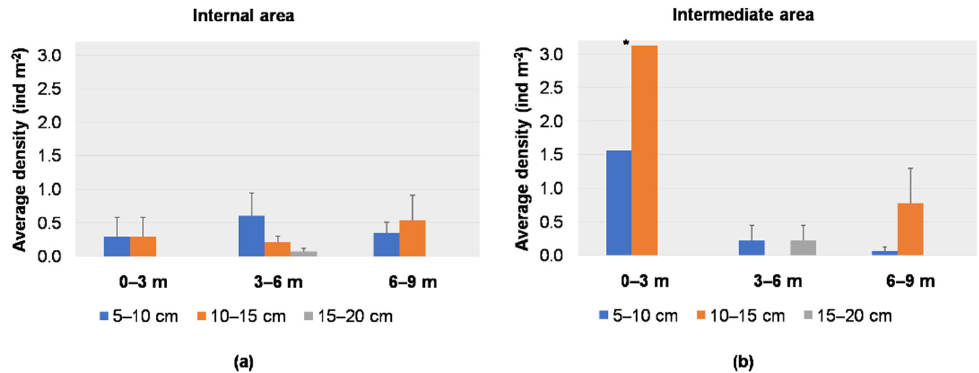
Figure 7. Average density (+S.E. as vertical bar) of Cassiopea andromeda individuals in the ( a ) internal sub-area and ( b ) intermediate sub-area; * one sampling